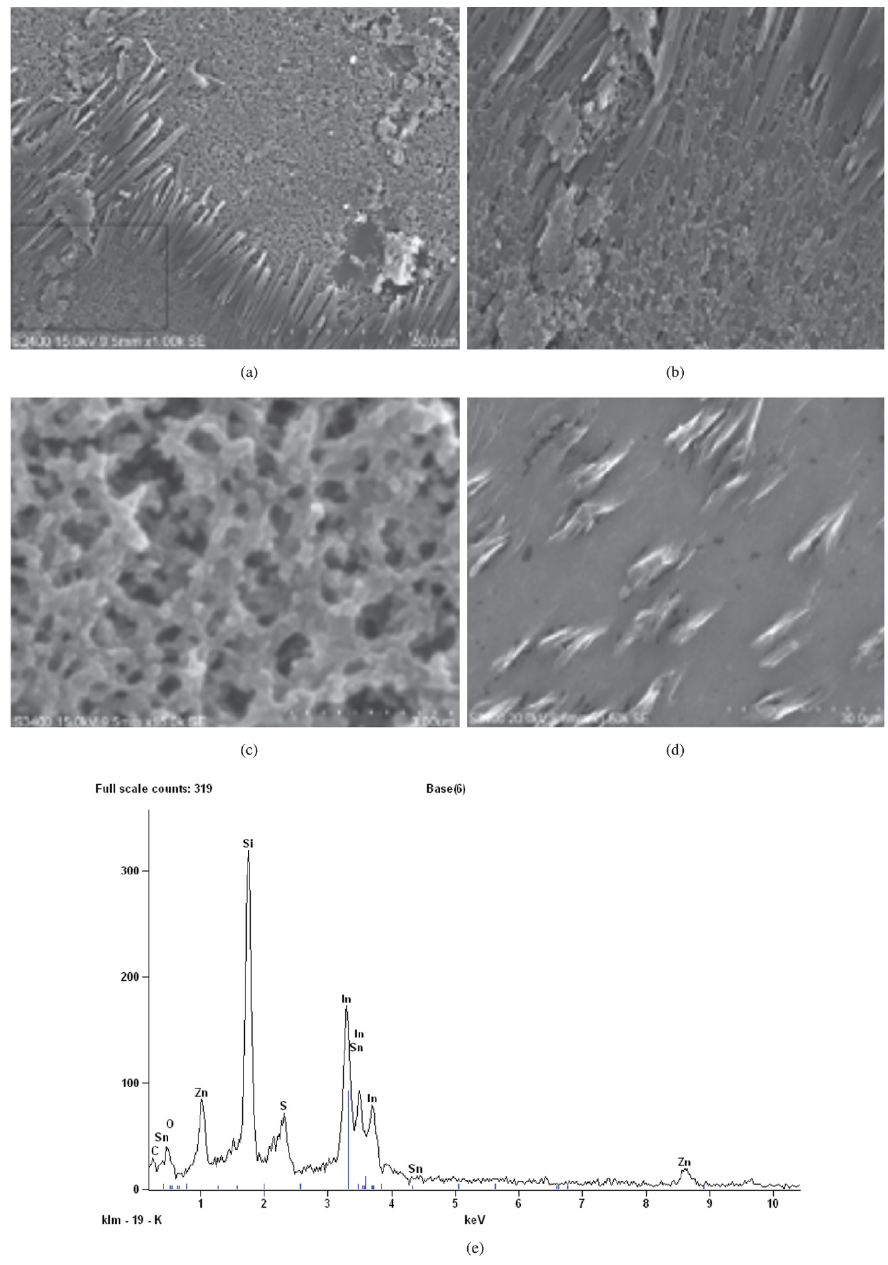
Figure 4. (a) SEM image Thin Film of CSA doped copolymer; (b) SEM image Enlarged image from Figure 4a; (c) SEM image thin film of CSA doped copolymer; (d) SEM image ZnO dispersed CSA doped copolymer; (e) EDAX spectrum of CSA doped copolymer with ZnO nanoparticles thin